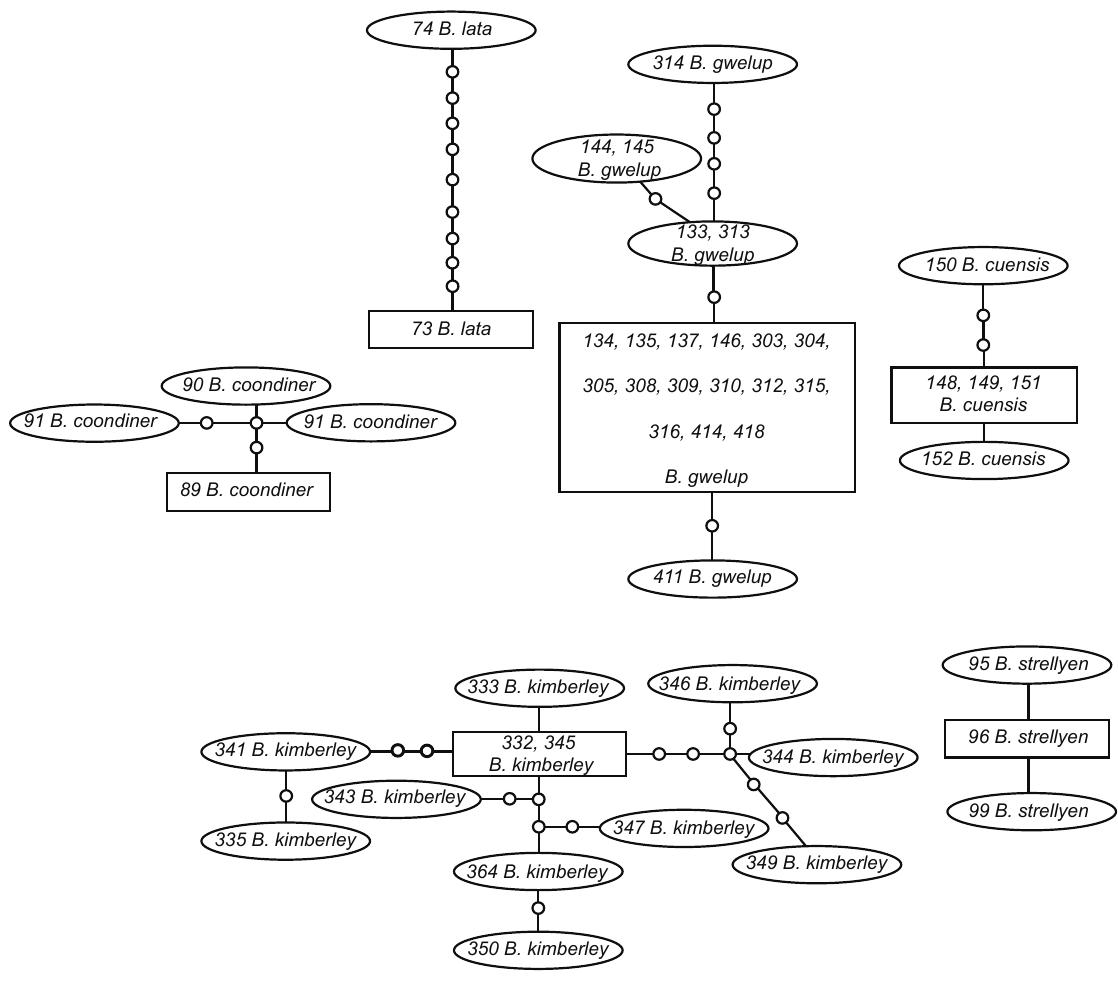
Fig. 3. Parsimonious network, based on COI sequences of Bennelongia . Squares represent ancestral sequences (or haplotypes), small circles missing haplotypes. The size of squares and large circles is proportional to the number of individuals with the same sequence in the analyses population. The network was constructed at the 95% probability limit, which usually includes up to 8 steps for connecting different sequences (or haplotypes). Thus, the two sequences of B. lata being 10 mutational steps apart needed to be connected manually by lowering the connection probability. The specimens belonging to the B. australis group form four groups, consisting of the species B. gwelupensis sp. nov., B. coondinerensis sp. nov., B. lata sp. nov. and B. cuensis sp. nov., while the specimens belonging to the B. pinpi group forms two distinctive lineages, with B. kimberleyensis sp. nov. and B. strelleyensis sp. nov. from the Kimberly and the Pilbara,